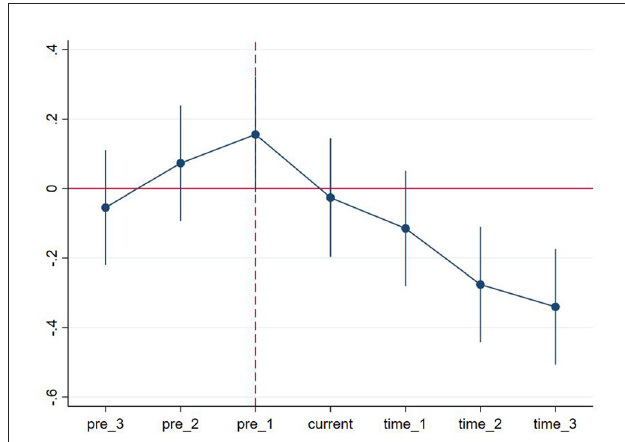
FIGURE5 Parallel trend test of sulfur dioxide intensity in the experimental and control groups.